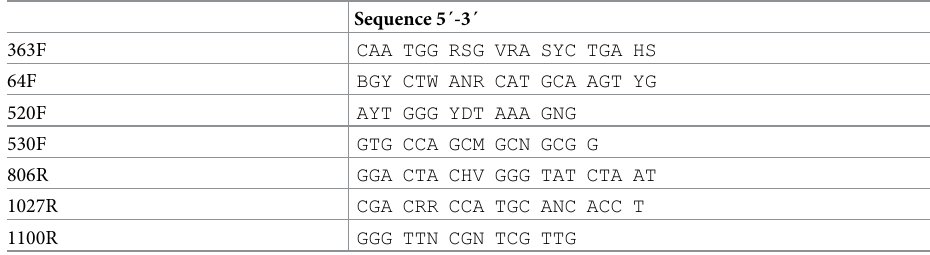
Table 1. Sequences of primers used in this